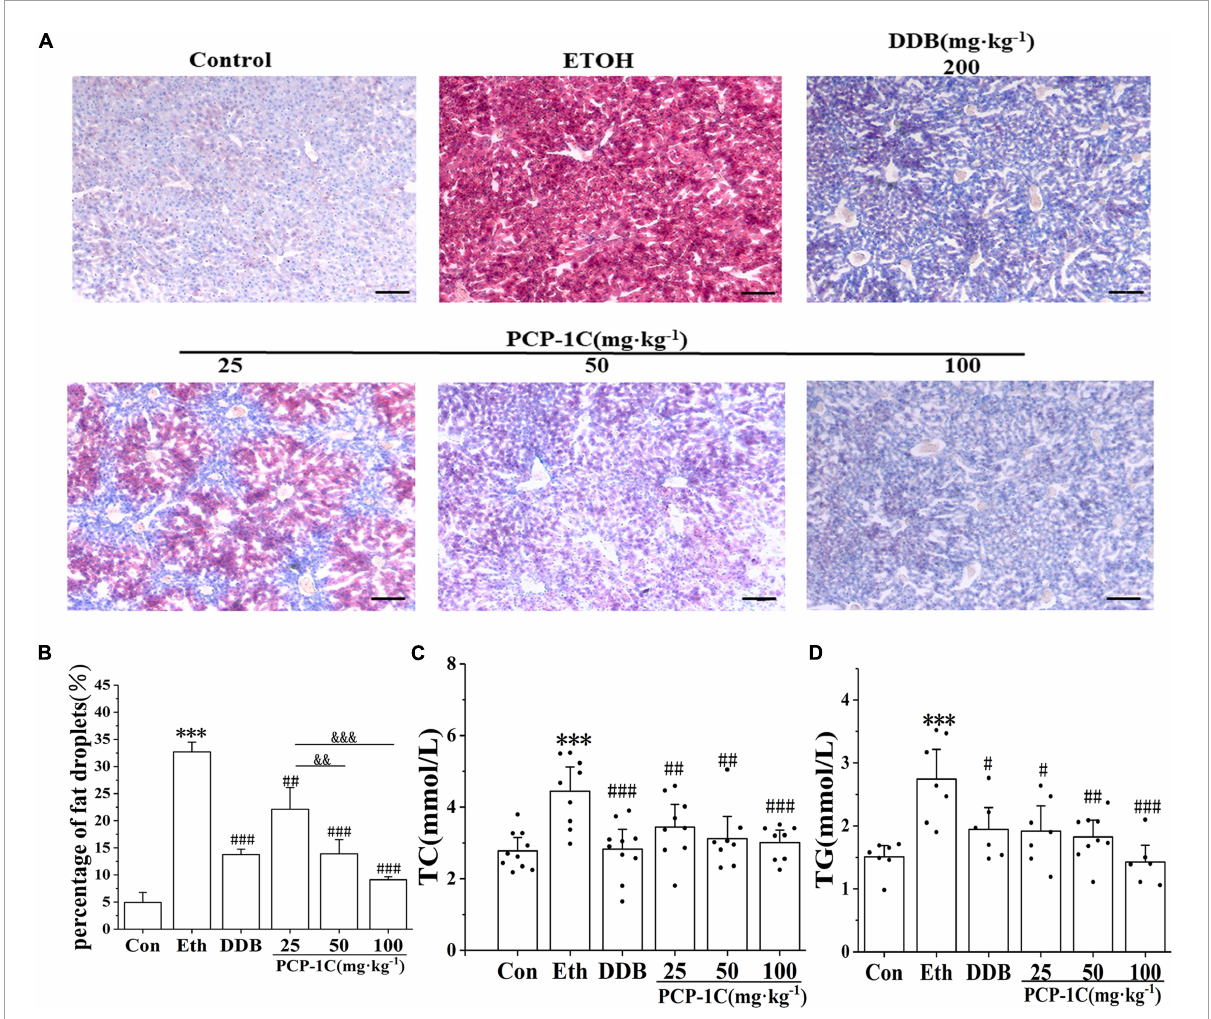
FIGURE2 Effects of PCP-1C on hepatic steatosis and lipid accumulation in ALD mice. (A) Liver Oil Red O-staining ( × 200, scale 50 µ m), (B) quantification of fat droplets from Oil Red O-staining, (C) serum TC levels, (D) serum TG levels. The results are presented as mean ± SD ( n ≥ 6). ∗∗∗ P < 0.001 vs. the control group; # P < 0.05, ## P < 0.01, ### P < 0.001 vs. the model group. && P < 0.01, &&& P < 0.001 represents significance between PCP-1C